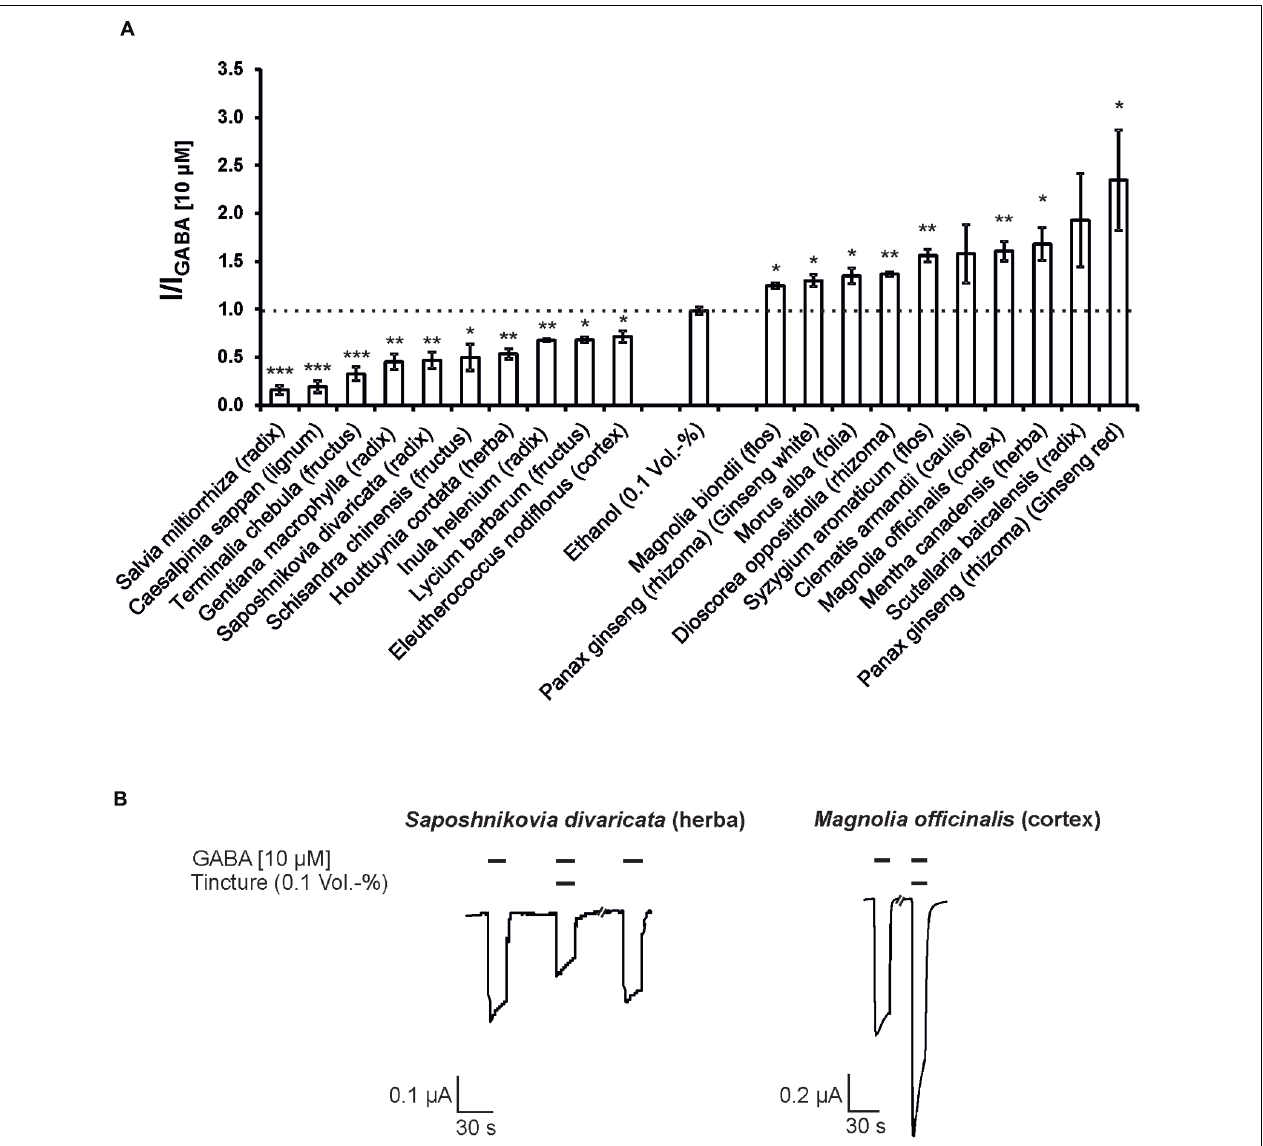
FIGURE 3 | The modulatory action of the strongest inhibitory and potentiating Kampo tinctures on the GABA A receptors. (A) The tinctures with the 10 strongest antagonistic (left) and potentiating (right) effects are shown (10 µ M GABA). Statistical significance was calculated based on the reference solution containing 0.1 Vol.-% ethanol (equal to the max. ethanol concentration in the tinctures; ∗ p < 0.05, ∗∗ p < 0.005, ∗∗∗ p < 0.0005; n = 3–8). (B) Original registrations of the modulation observed via Saposhnikovia divaricata (herba) and Magnolia officinalis (cortex) with a 1:1,000 dilution are shown. The effects were reversible following a 150-s washout with ringer’s